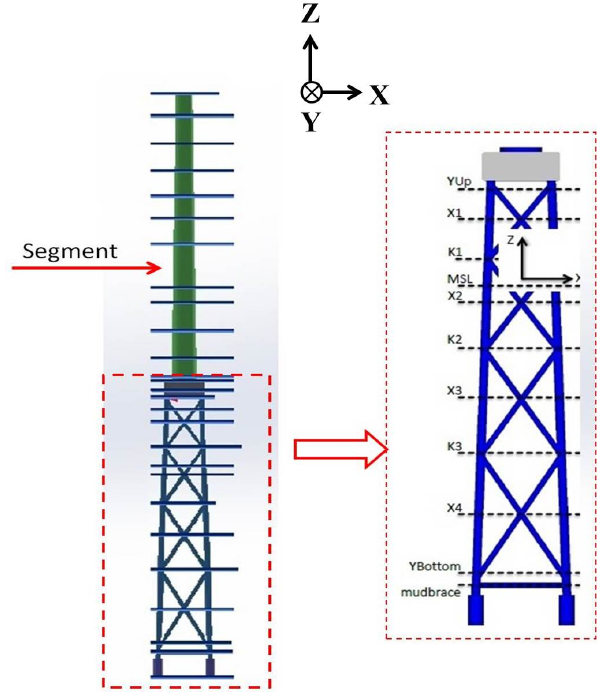
Figure 11. Segment Definition for Modal Analysis.